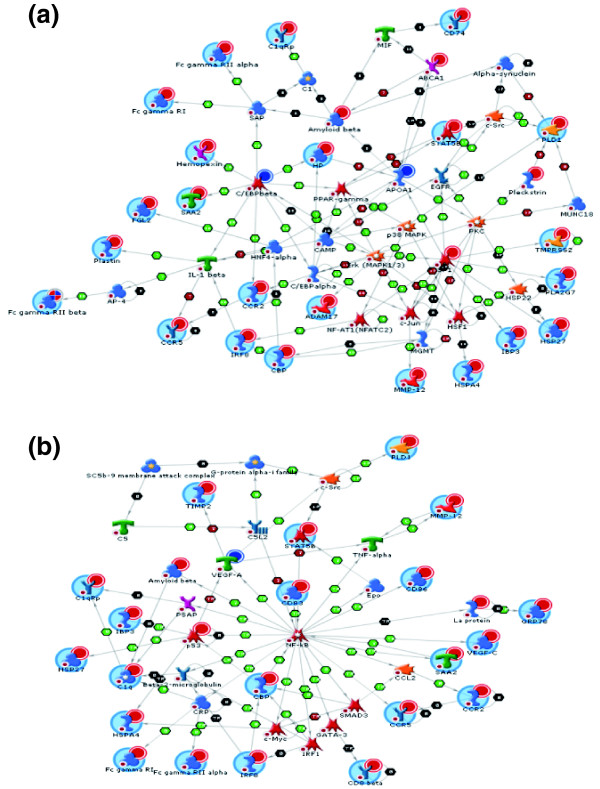
Representative biological network based on differentially expressed genes of the HC group using MetaCore™ network software and the Analyze Network algorithm. Two representative networks are shown: (a) the C/EBPβ c-jun network and (b) the NF-κB network. A legend for the biological networks is provided in Additional data file 7d. Red dots in the right corner of a gene indicate up-regulation and blue dots down-regulation.